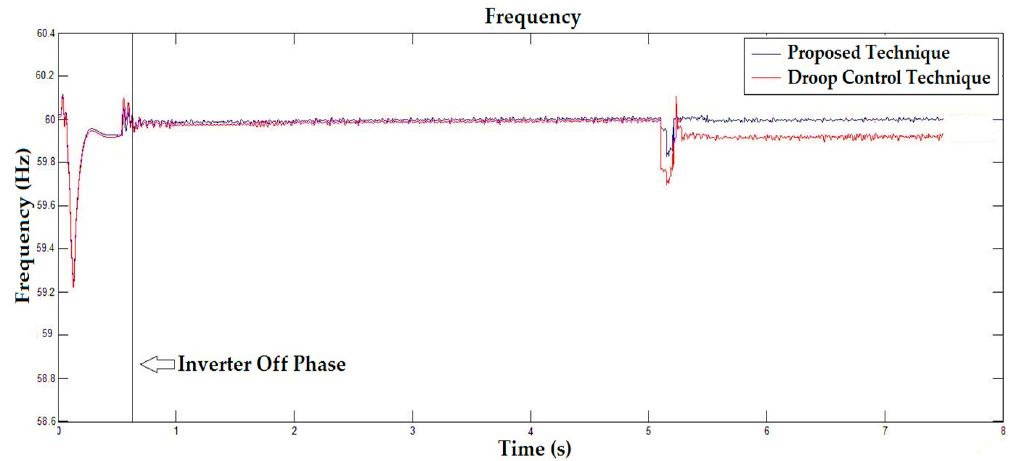
Figure 20 . Battery SOC in system overloading mode.